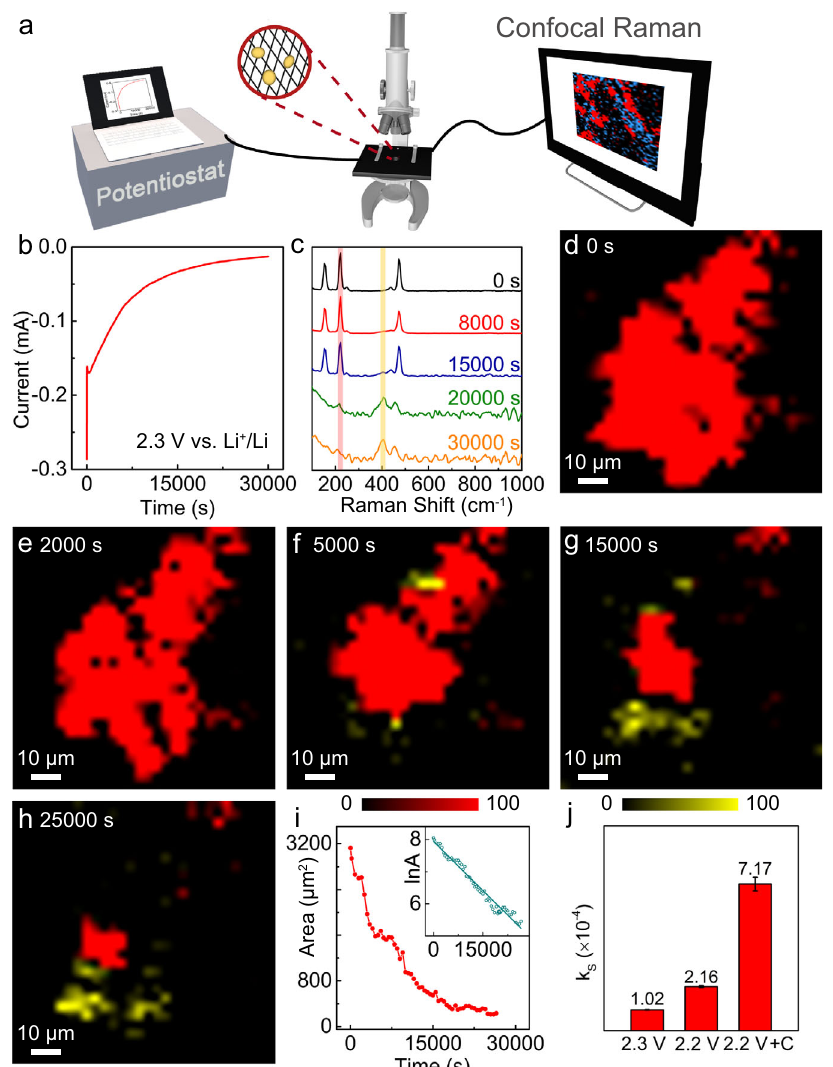
Fig.1|Reductionofsulfurclustersat2.30Vvs.Li + /Li.a Schematicillustrationof the operando confocal Raman microscopy experimental setup for probing the mechanism and kinetics of Li – S redox processes. b Chronoamperometric current- time transient of sulfur reductionat2.30V (vs. Li + /Li). Operando Raman( c )spectra and ( d – h ) mapping images of the sulfur electrode during reduction. The red and yellow colors in ( d – h ) represent sulfur and long-chain polysul fi des, respectively,